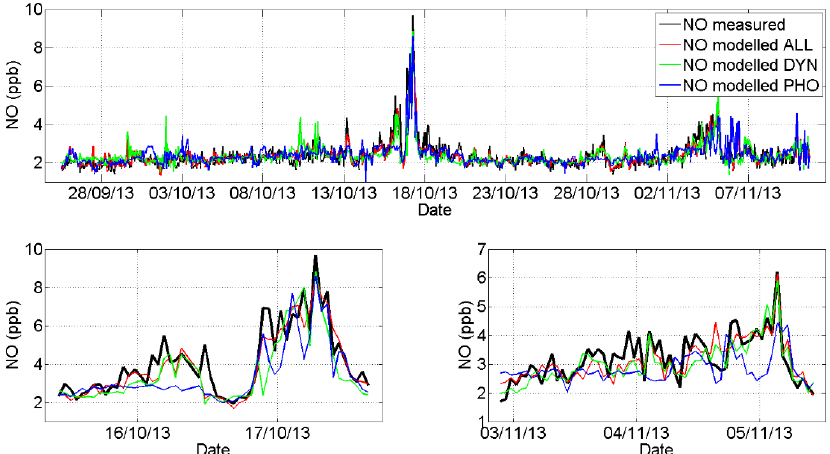
Figure 5. As Figure 4 but the modeled time series are the output of simulation without the inclusion of the O 3 as input nodes.